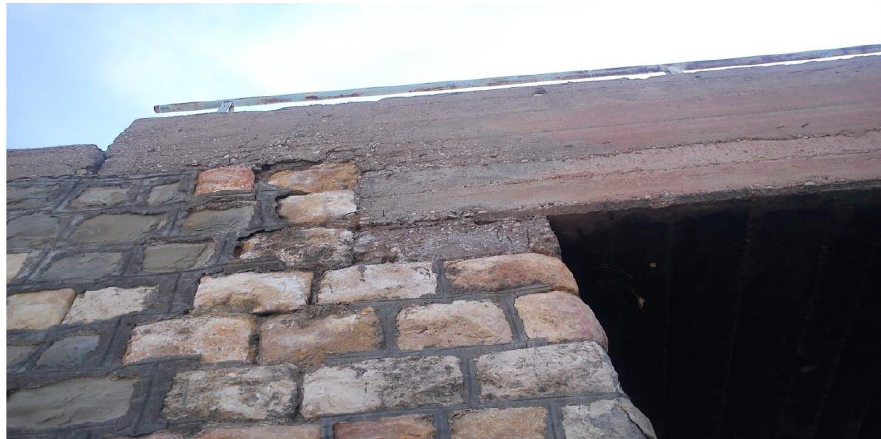
Figure 17. The structural damage in bridge NO. 4.